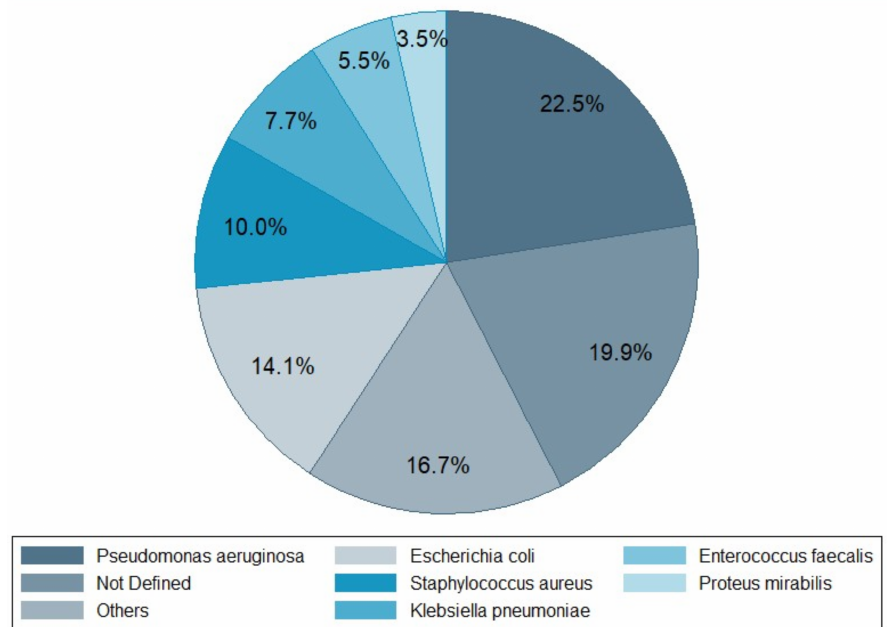
Figure 3. Relative prevalence of 311 reported bacterial pathogens (Table